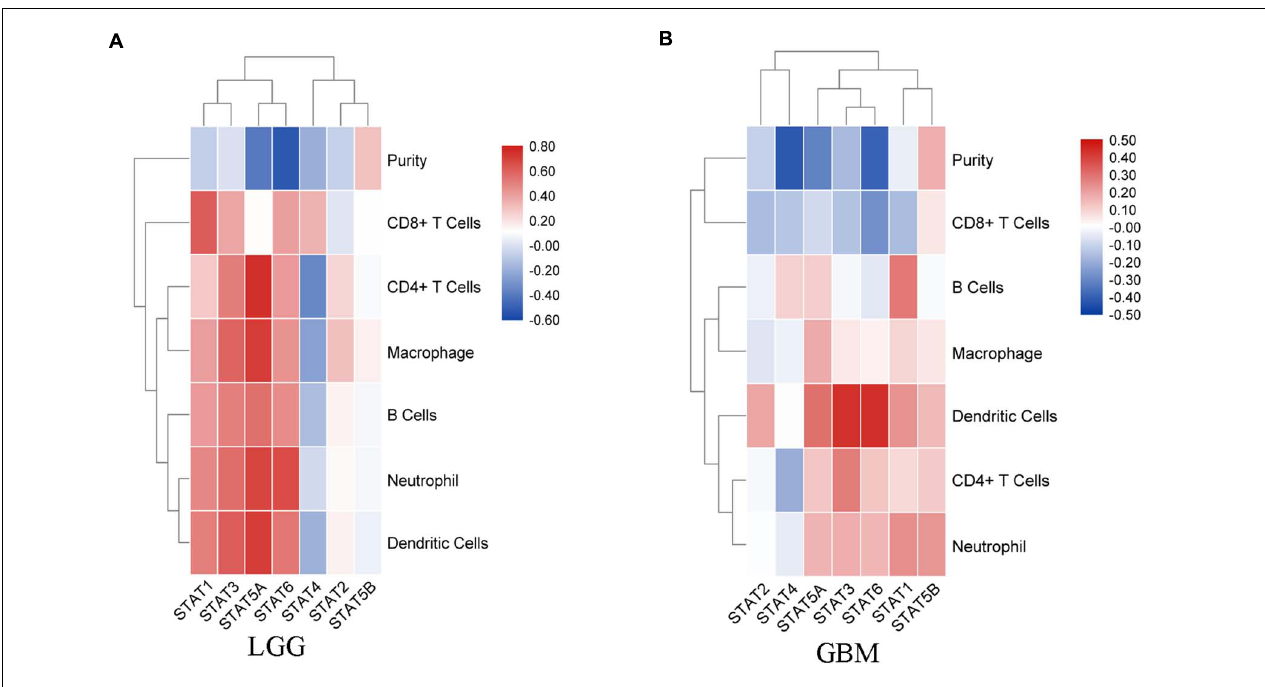
FIGURE 7 | Correlation analysis between STAT genes and TIICs. (A) Correlation between STATs and each type of TIICs (B-cells, CD4 + T-cells, CD8 + T-cells, neutrophils, macrophages, and dendritic cells) in LGG; (B) Correlation between STATs and each type of TIICs (B-cells, CD4 + T-cells, CD8 + T-cells, neutrophils, macrophages, and dendritic cells) in